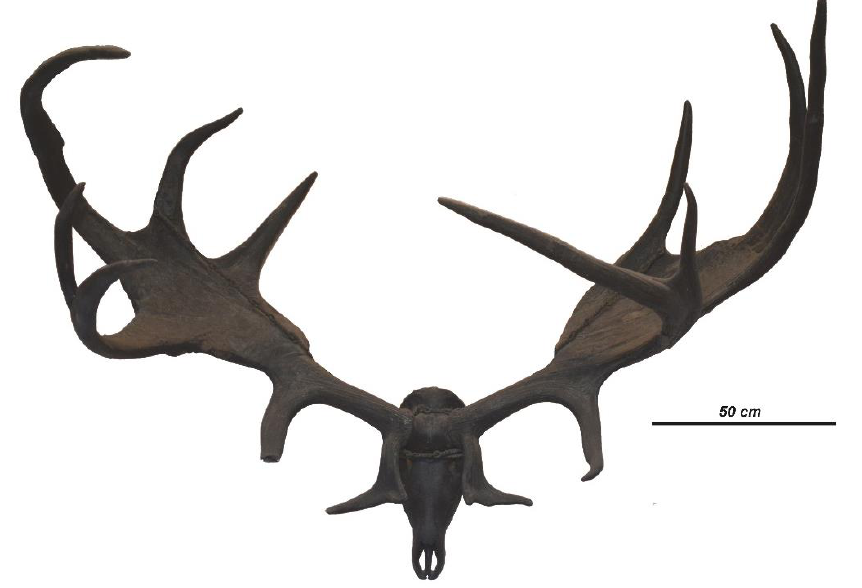
Figure 6. The antlered skull of Megaloceros giganteus megaceros (Hart, 1825) from Barmeath Castle (Ireland).